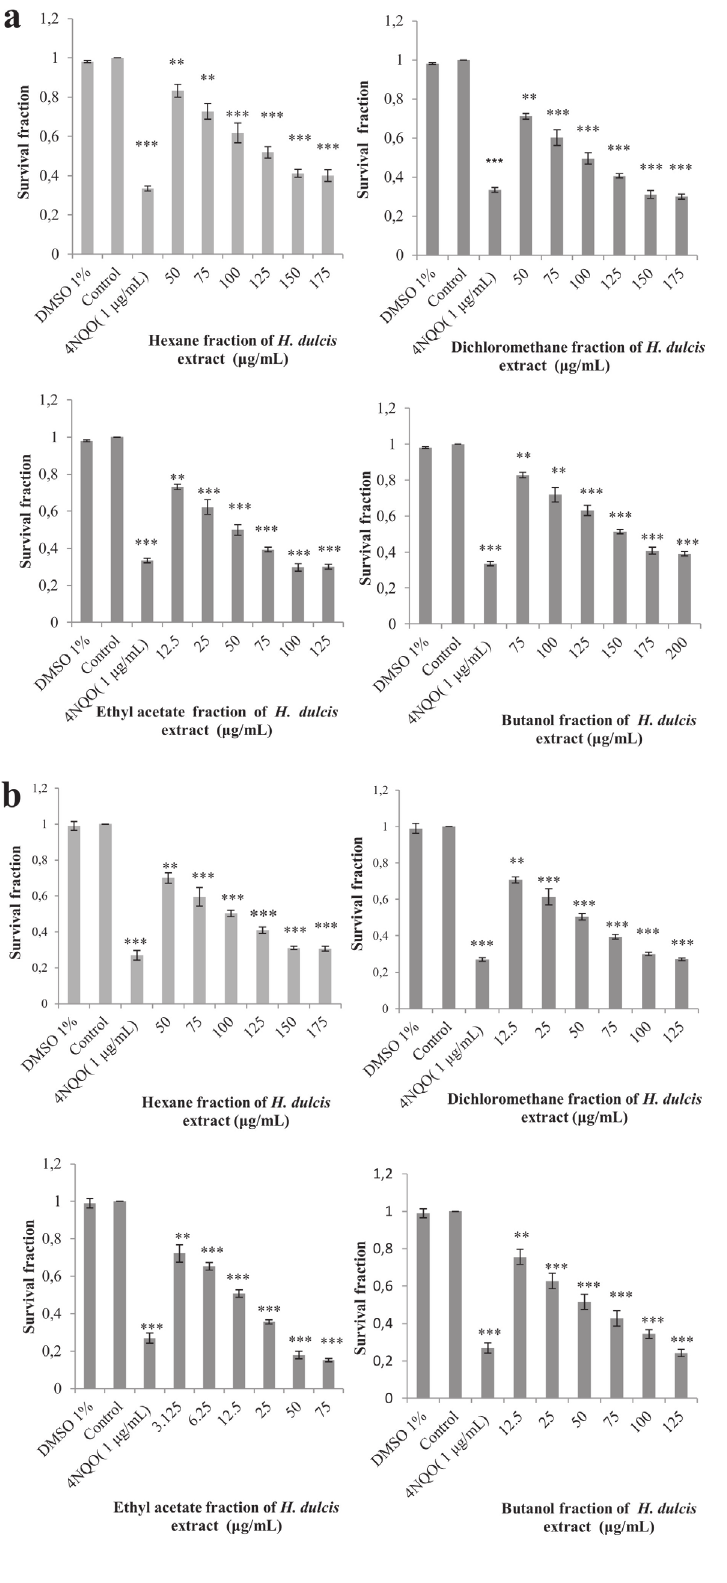
Figure 1(a). Survival fraction of S. cerevisiae strain FF18733 (b) Survival fraction of S. cerevisiae strain CD138 treated with different concentrations of the H. dulcis ethanolic extract. Evaluation after 60 min of treatment with H. dulcis extract fractions ** ( p <0.01) *** ( p <0.001) compared to